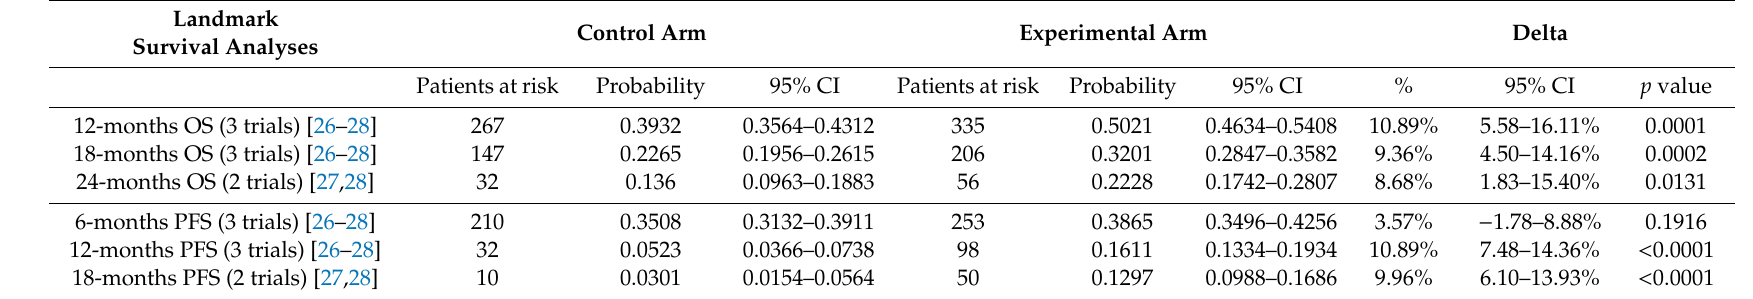
Table 3. Pooled landmark analyses for OS and